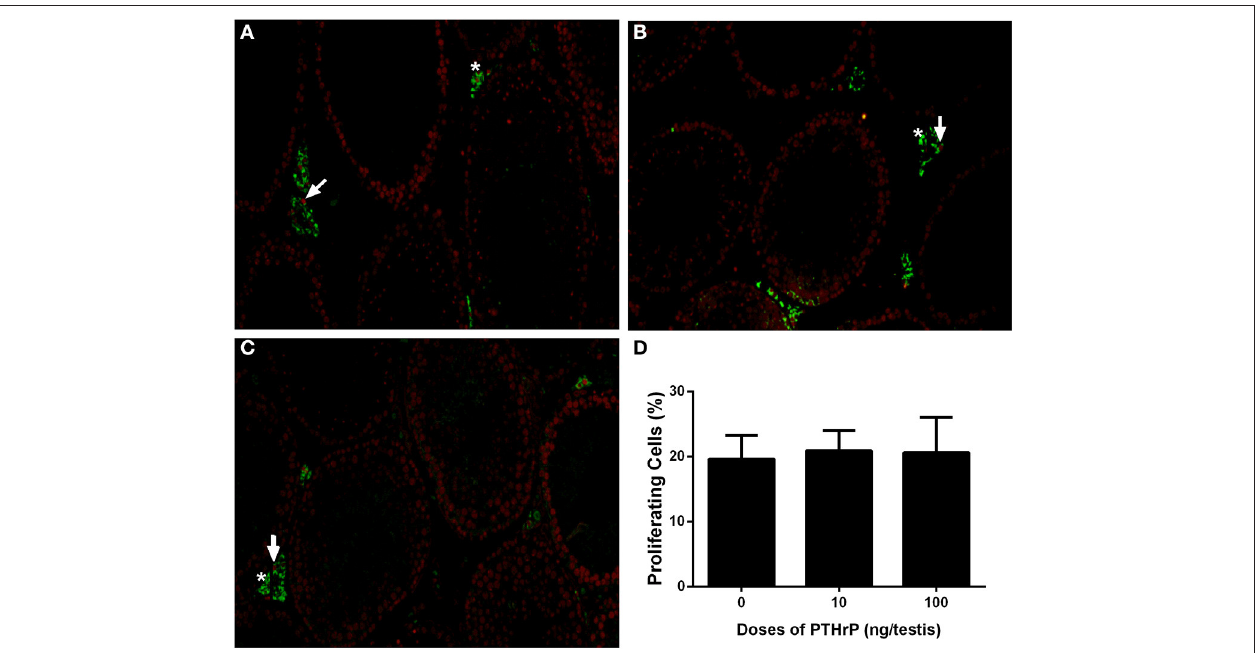
FIGURE 7 | PTHrP does not affect proliferation of Leydig cells in vivo . Immunofluorescent staining of PCNA (red color in the nucleus) and 11 β -HSD1 (green color in the cytosol) of the testes from the rats treated with 0 (A) , 10 (B) , and 100 (C) ng/testis PTHrP on post-EDS day 7 for 21 days. (D) : Quantitative data. White arrow indicates PCNA-positive Leydig cells. White “*” indicates PCNA-negative Leydig cells. Mean ± SEM, n = 6. No significant difference between PTHrP group and the control was